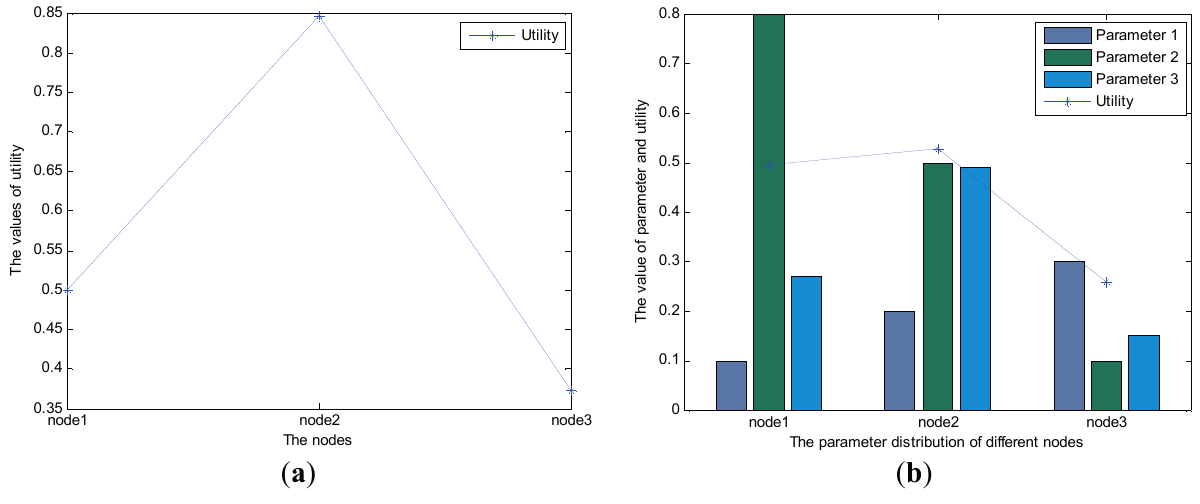
Figure 2. ( a ) The result of the traditional fuzzy logic-based algorithm (used in [19,20]) with the raw data; ( b ) The result of the new routing algorithm with the data in Table